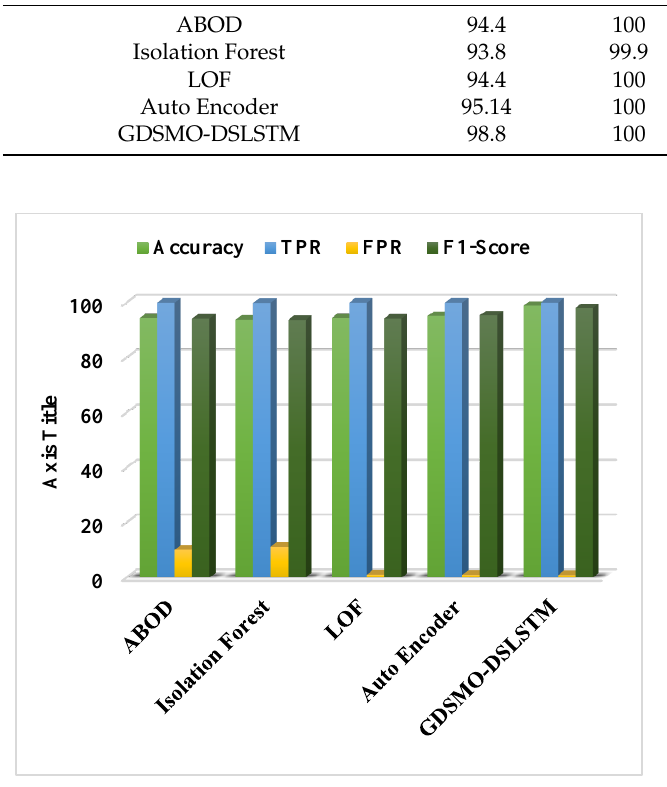
Figure 17. Comparison between existing and proposed classification techniques based on the measures of accuracy, TPR, FPR, and F1-score. Table 5. Accuracy, detection rate, and F1-score of existing and proposed classification techniques using the SCADA network dataset.